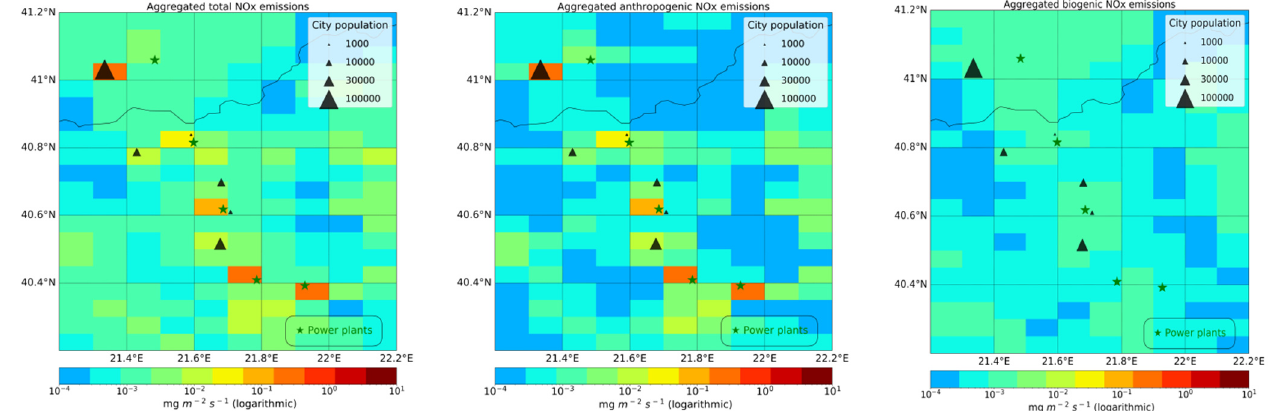
Figure 3. NO x emissions used in the model in the summer of 2019. ( a ) Total emissions; ( b ) Anthropogenic emissions; ( c ) Biogenic emissions 2019. The green stars denote the power plant locations and the size of the black triangles represent the size of city